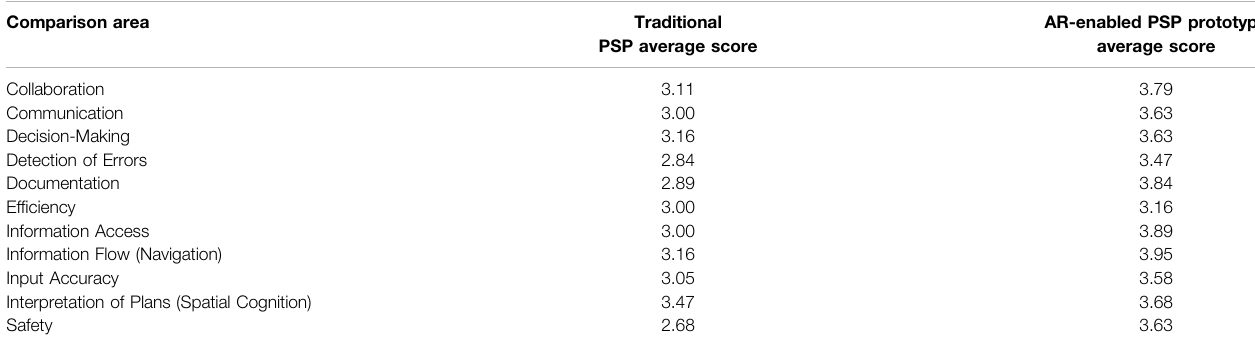
TABLE 6 | Average scores for the 11 areas of comparison. Comparison